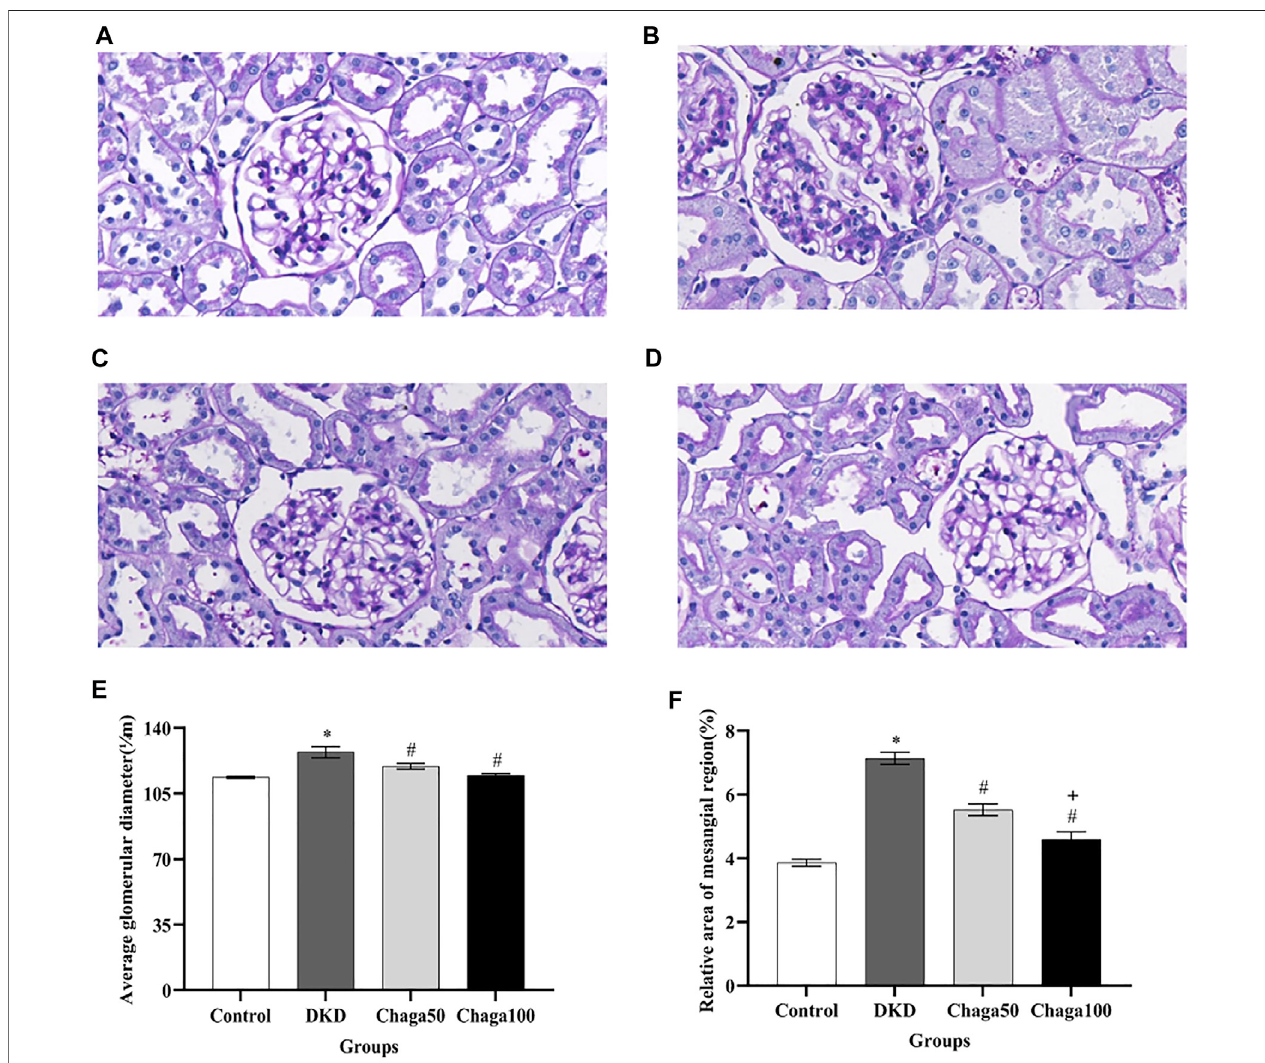
FIGURE 5 | Effects of chaga on the pathological parameters of DKD rat model under the light microscope. (A – D) Light microscopic images of glomerulus (PAS staining × 400). (A) Normal control group. (B) DKD model group. (C) Chaga50 group. (D) Chaga100 group. (E) Average glomerular diameter of rats in each group. (F) Relative area of the mesangial region of rats in each group. Data were presented as mean ± SE. DKD, diabetic kidney disease; Chaga50, treatment with 50 mg/kg of chagagroup;Chaga100,treatment with100 mg/kg ofchaga group. * p < 0.05 vs. Normalcontrol group,# p < 0.05vs. DKDgroup, + p < 0.05vs. Chaga50 group.